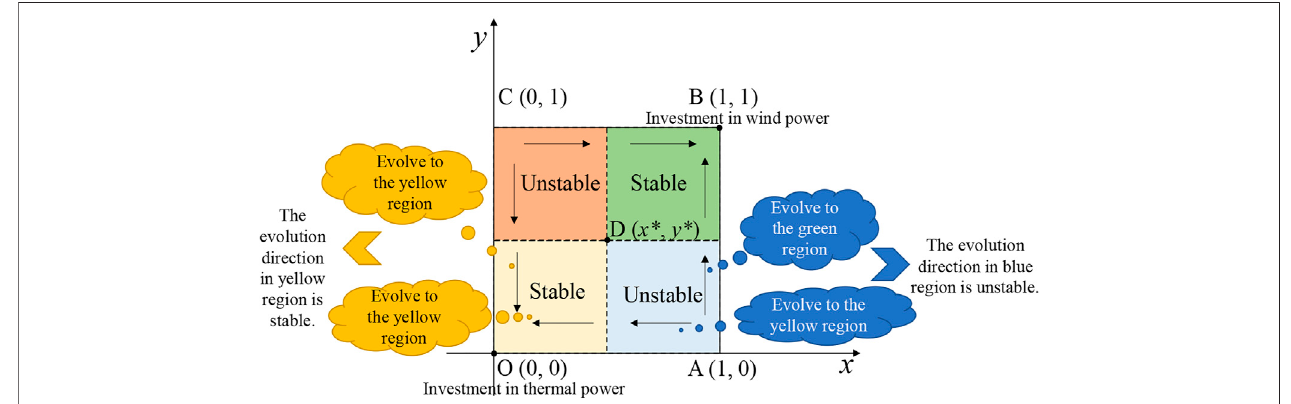
FIGURE 2 | Phase diagram of investors evolution